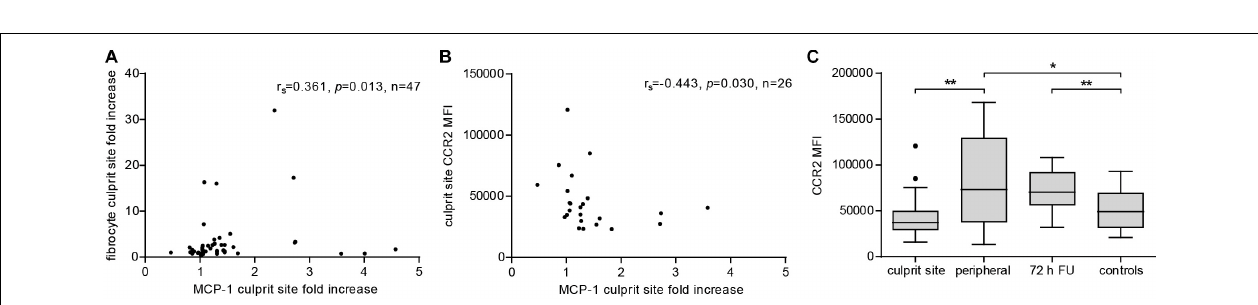
FIGURE 3 | MCP-1 primes neutrophils for NET formation. (A) Leukocytes of healthy donors ( n = 8) were treated with 500 pg/ml of MCP-1 for 2:30 h and analyzed by flow cytometry. Data are presented as percentage of CD66b-positive cells staining for citH3. Groups were compared by Wilcoxon matched-pairs signed rank test. (B) Neutrophils of healthy donors ( n = 12) were pre-treated with 125, 250, and 500 pg/ml MCP-1 and then stimulated with 1.3 µ M ionomycin (IM) to induce formation of NETs. Data are provided in percent of positive control and are presented as mean ± SD. Experiments were analyzed by repeated measures ANOVA followed by Dunnett’s multiple comparisons test using the group treated with 1.3 µ M IM as single comparator. * p < 0.05, *** p < 0.001, **** p < 0.0001.